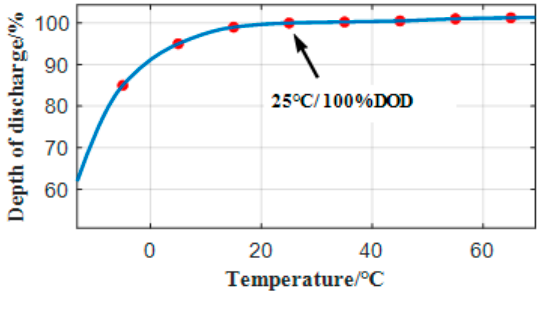
Figure 4. Temperature-DOD. Figure 4.